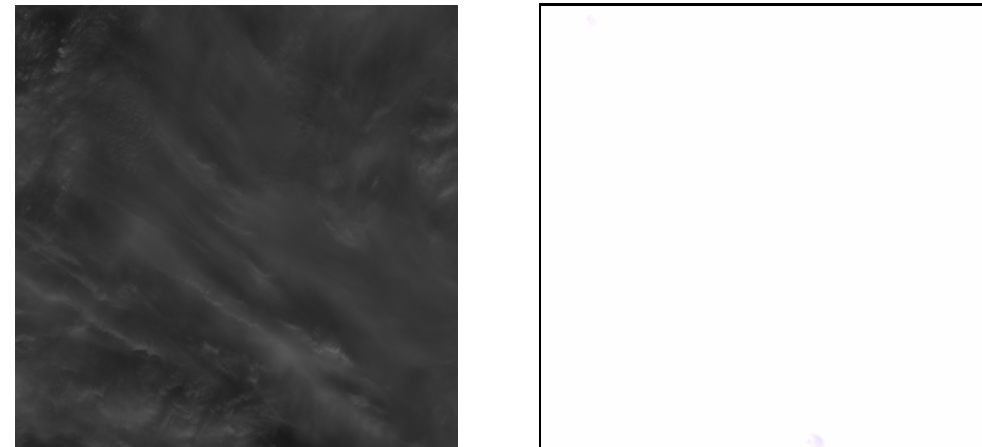
Figure 13. Example of a bright overcast scene over Timisoara on 27 December 2021. Band 4 ( left ) and TCI ( right ). The TCI image is almost completely white with some spots of darker pixels in the upper left and bottom of the